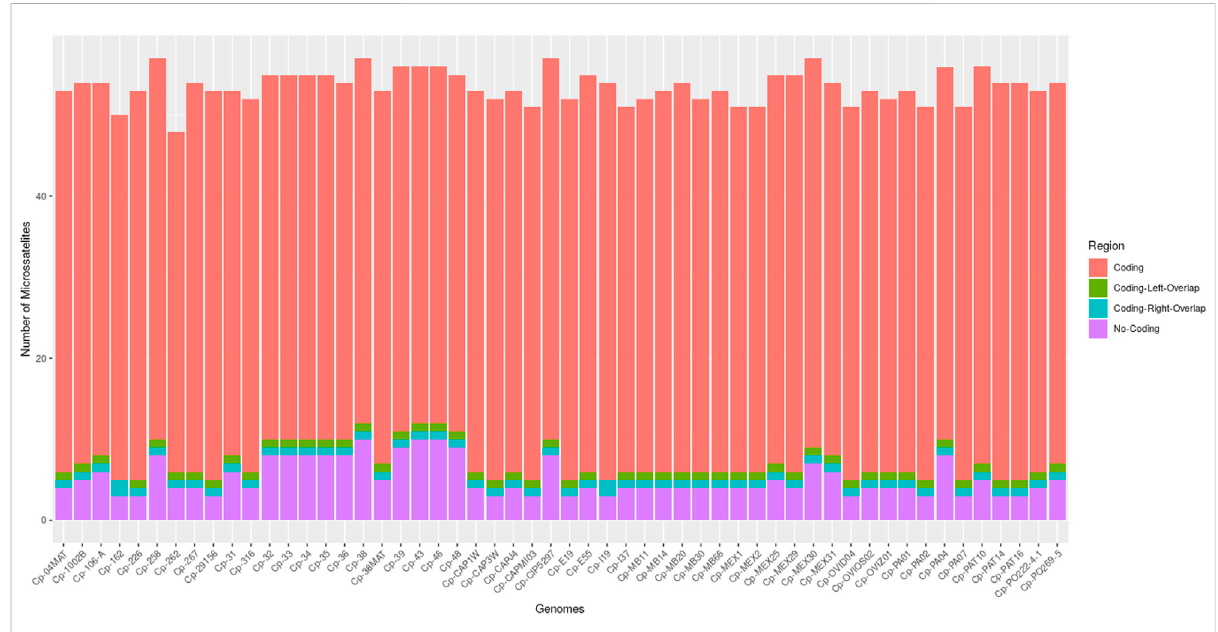
FIGURE 1 Bargraphshowingthenumberofmicrosatellitesfoundinthe54genomesof C.pseudotuberculosis ,dividedintofourcategories:coding,non- coding, coding left overlap, and coding right